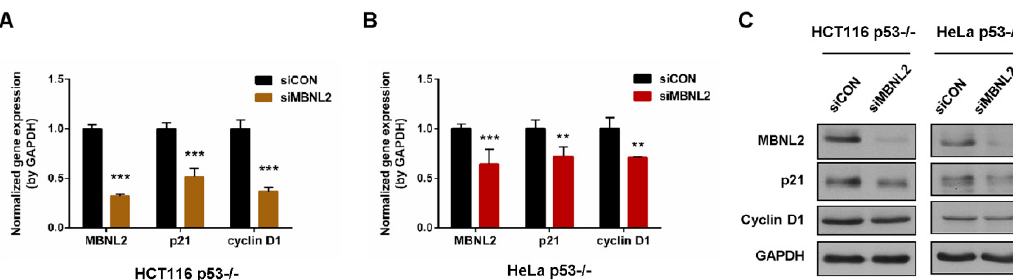
Figure 2. MBNL2 regulates p21 expression independently of p53. ( A ) The mRNA levels of MBNL2, p21, and cyclin D1 were determined in the HCT116 p53 − / − or ( B ) HeLa p53 − / − cells transfected with control or MBNL2 siRNAs. ( C ) Immunoblotting of MBNL2, p21, and cyclin D1 in the HCT116 p53 − / − or HeLa p53 − / − cells transfected with control or MBNL2 siRNAs. ** p < 0.01, *** p < 0.001.